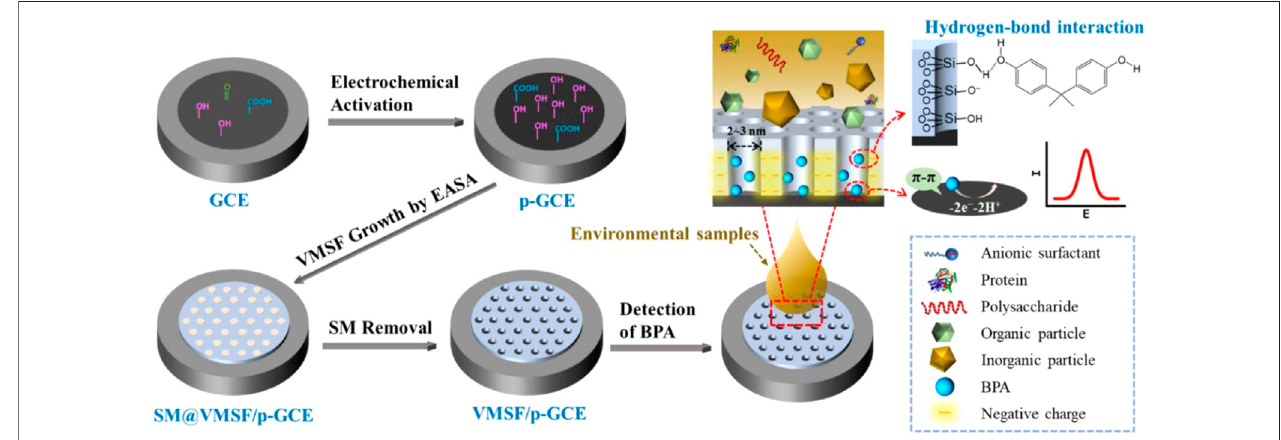
FIGURE 1 | Schematic illustration for the preparation of VMSF/p-GCE and the direct detection of BPA in complex environmental samples.